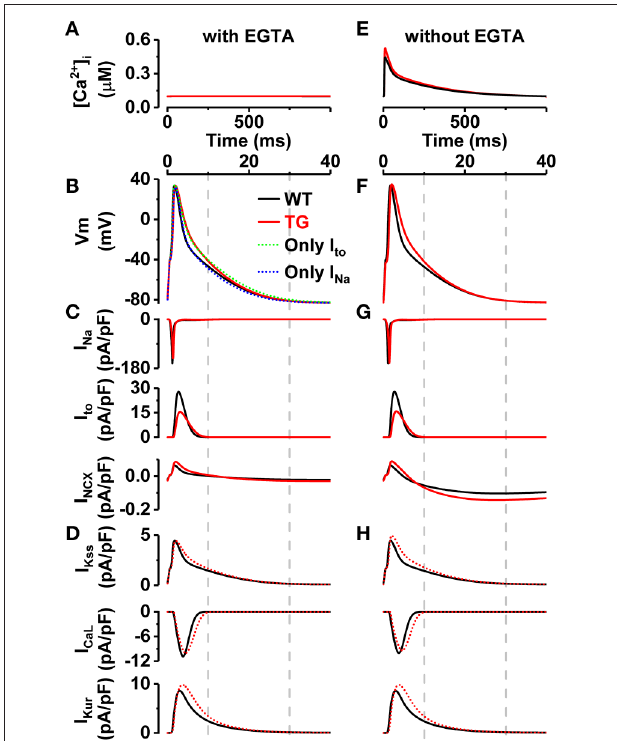
FIGURE 7 | Effect of VEGF-B-related electrophysiological alterations explored in silico . From top to the bottom: (A,E) [Ca 2 + ] i transients, (B,F) action potentials, (C,G) currents introduced into model I Na , I to , I NCX (solid red lines), and (D,H) resulting currents I Kss , I CaL , I Kur (dotted red lines) in simulated pacing experiments, in the presence (A–D) and absence (E–H) of EGTA. Note, the different time scale in [Ca 2 + ] i transients panels. The VEGF-B TG model variant (red lines) accounts for the (1) decreased I Na ( − 18%), (2) reduced I to (conductance − 49%, and inactivation rate + 59%), and (3) increased NCX current ( + 36%) as found in